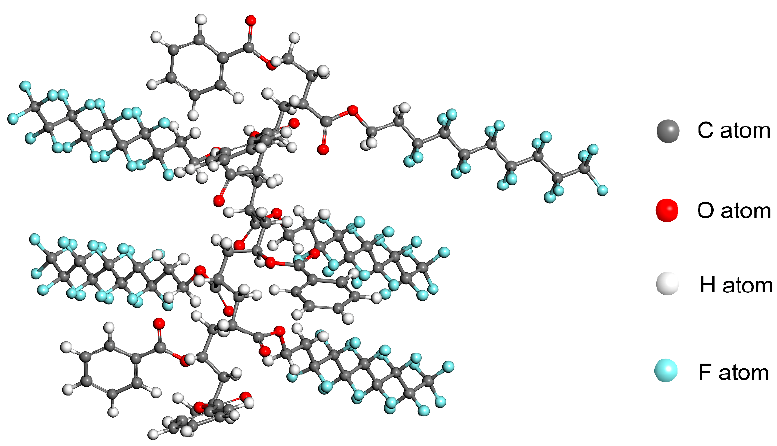
Table 1. The systems simulated by all-atom molecular dynamics.